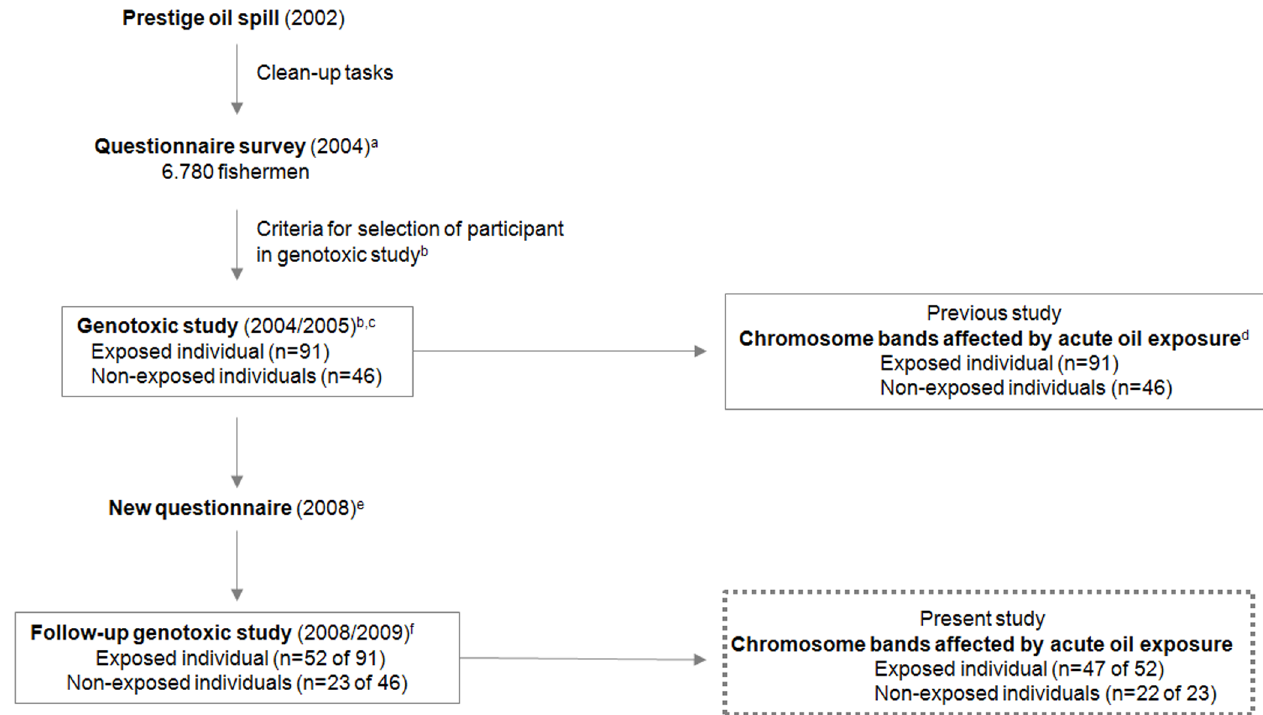
Fig 1. Flow diagram of the study. a Detailed description in 22, b Detailed description in 13, c Detailed description in15, d Detailed description in14, e Detailed description in 23, f Detailed description